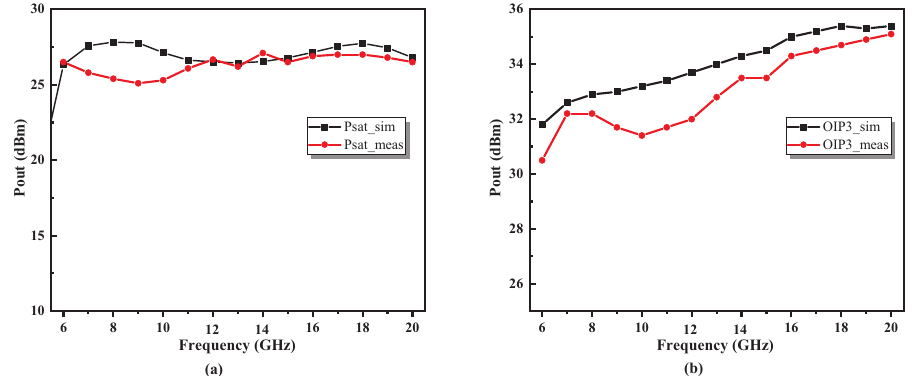
Figure 11. Experimental results of the proposed driver amplifier. ( a ) Comparison between simulated and measured large-signal results. ( b )